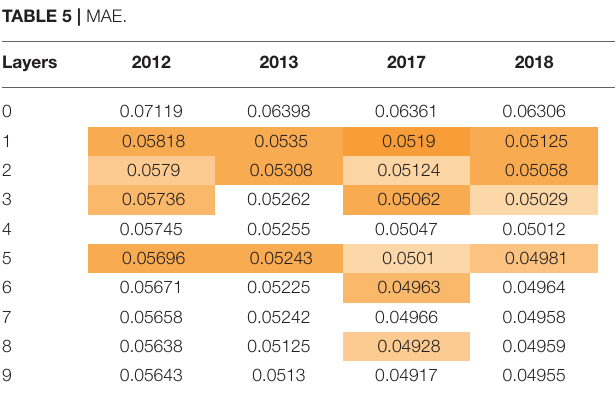
Darker shades represent lower p-values, e.g. a stronger statistical significance.